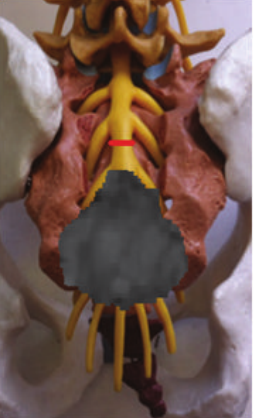
Figure 8: Soft tissues intentionally left behind and included in the specimen to be resected. Figure 9: Thecal sac ligation distal to S2 nerve roots (red